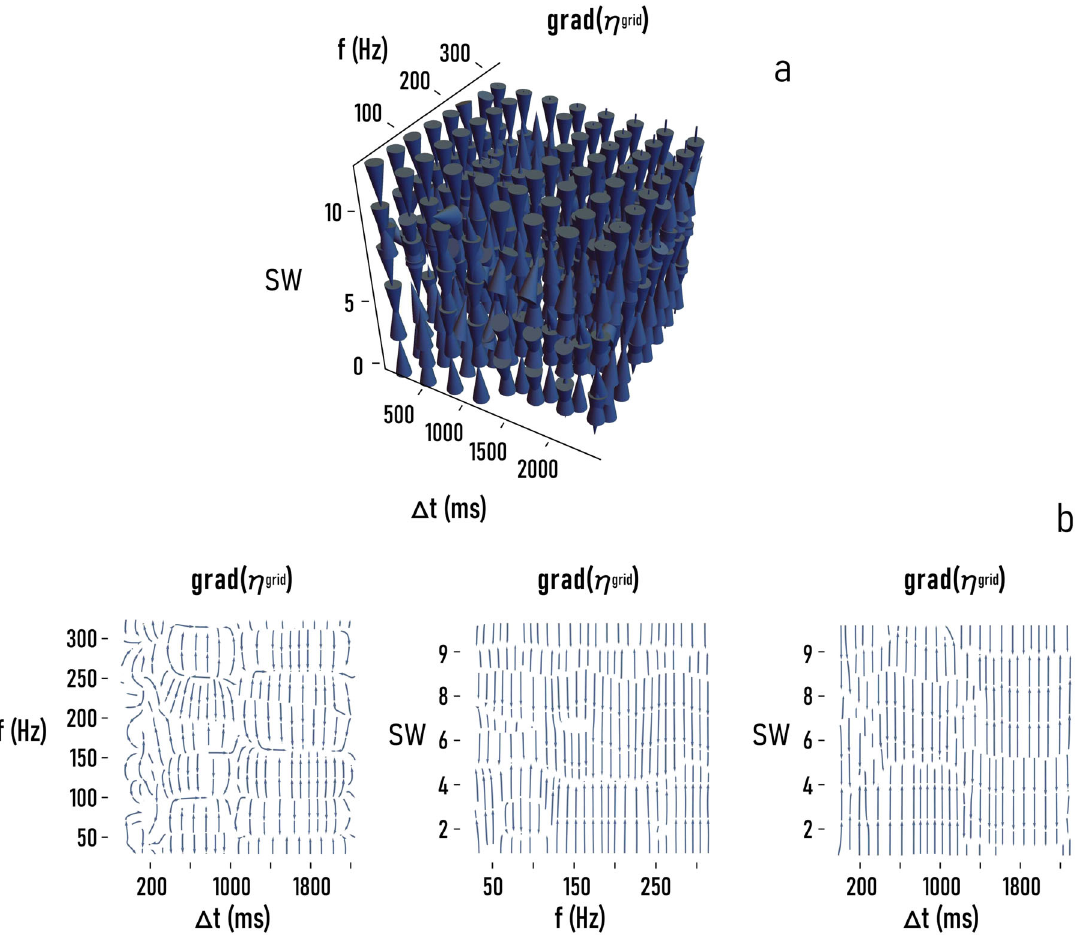
Fig. 6 The enhancement factor of total information in the grid η grid is a function of the model parameters: Δ t , f , and SW. To show that η grid exhibits a greater sensitivity to SW than to 4 t or f , we report in a the gradient of η grid ∇ η grid ∇ η grid as a function of those variables taken two at the